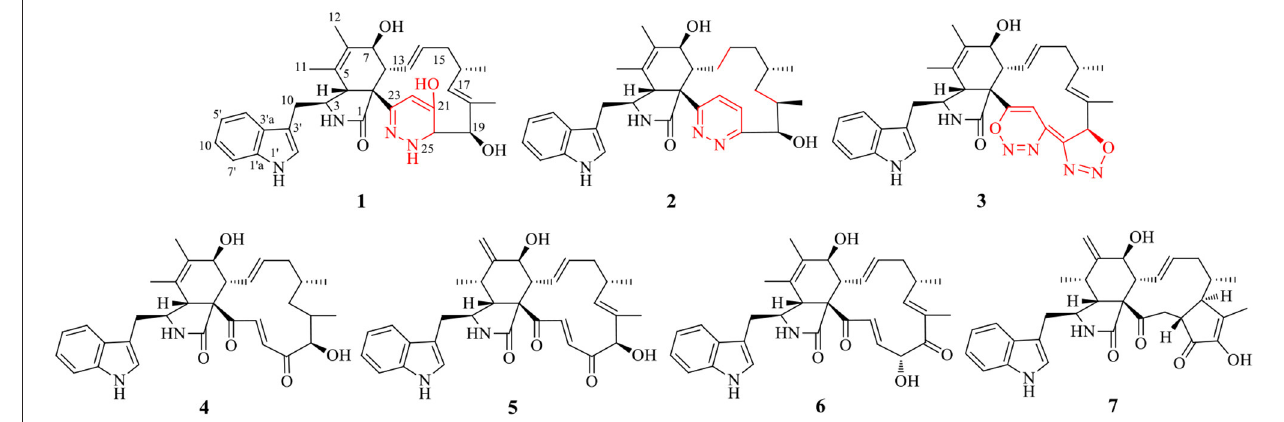
FIGURE 1 | Structures of obtained compounds 1 – 7 .